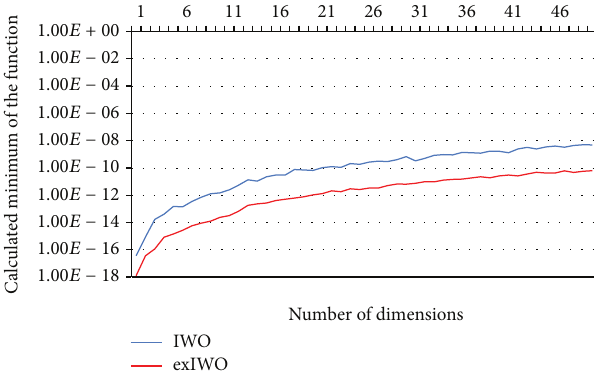
Figure 11: Comparison between IWO and exIWO based on the sphere function.